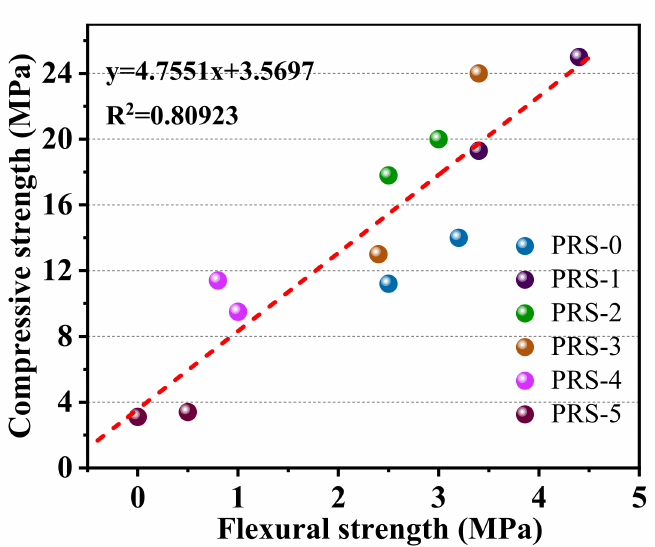
Figure 12. The relationship between the compressive strength and flexural strength of composite cementitious materials with different phosphogypsum